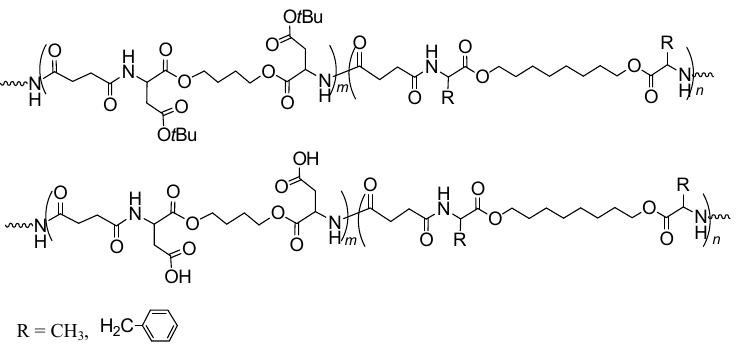
Figure 28. co -AABBP-polyacids composed of bis-( L -aspartic acid)-1,4-butylene diester.